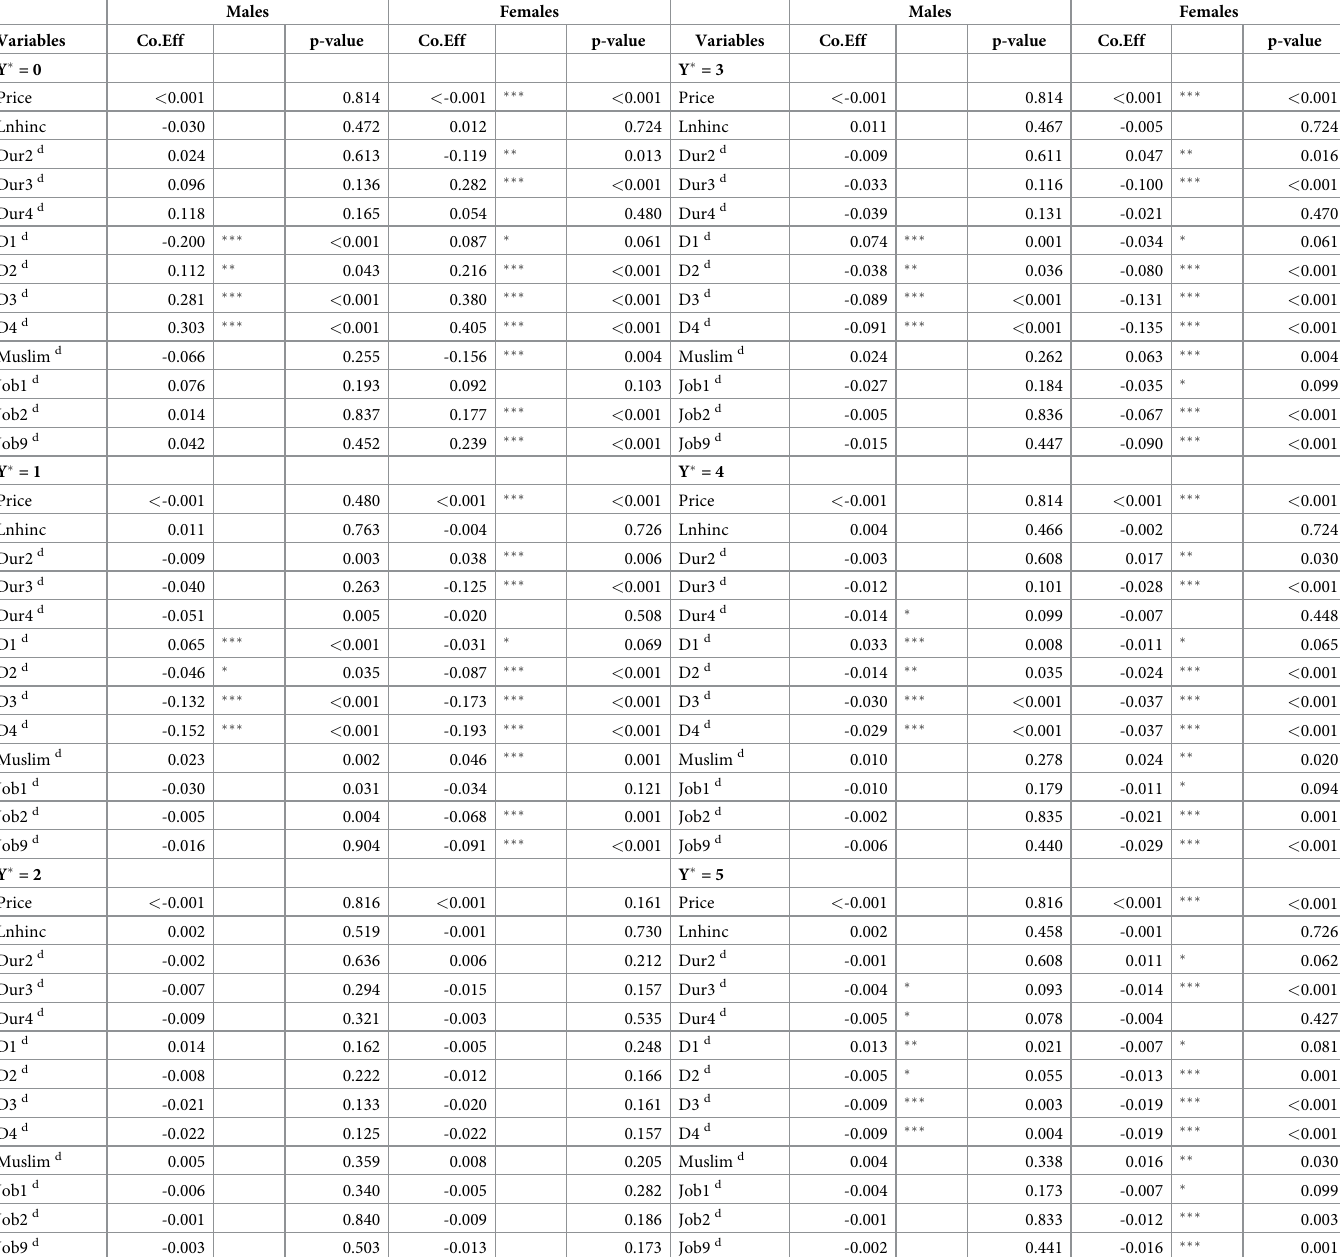
Table 4. Marginal effects from 12-month recall ZIOP model for unqualified providers, by gender. Males Females Males Females